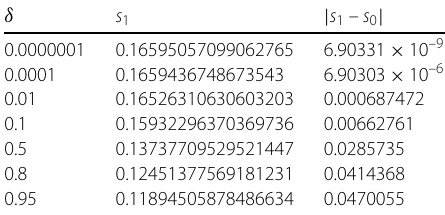
Table 1 Variation of s 1 and | s 1 – s 0 | with different values of δ δ s